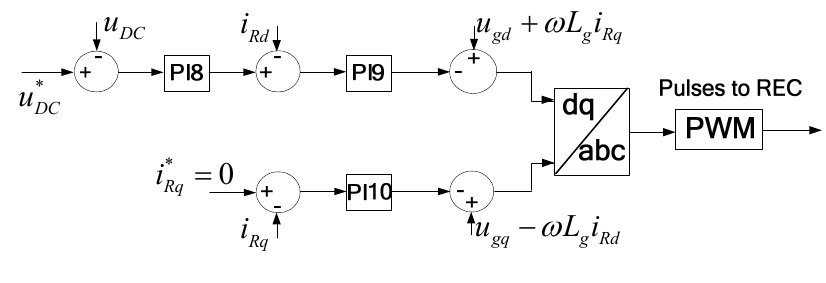
Figure 5. Control diagram of